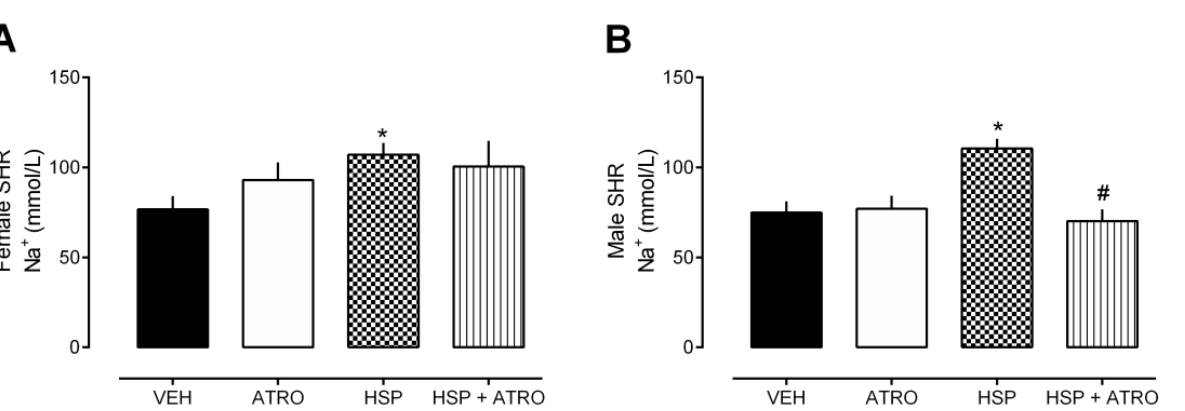
Figure 6. Urinary parameters (8 h) after oral treatment with hesperidin (HSP) in the presence of atropine (ATRO) or indomethacin (INDO). ( A , B ) Urine Na + excretion after treatment with HSP in the presence of ATRO. ( C , D ) Urine K + excretion after treatment with HSP in the presence of ATRO. ( E , F ) Urine Na + excretion after treatment with HSP in the presence of INDO. ( G , H ) Urine K + excre- tion after treatment with HSP in the presence of INDO. The values show the mean ± SEM. Statistical analysis was performed by means of one-way ANOVA followed by Dunnett ’ s multiple